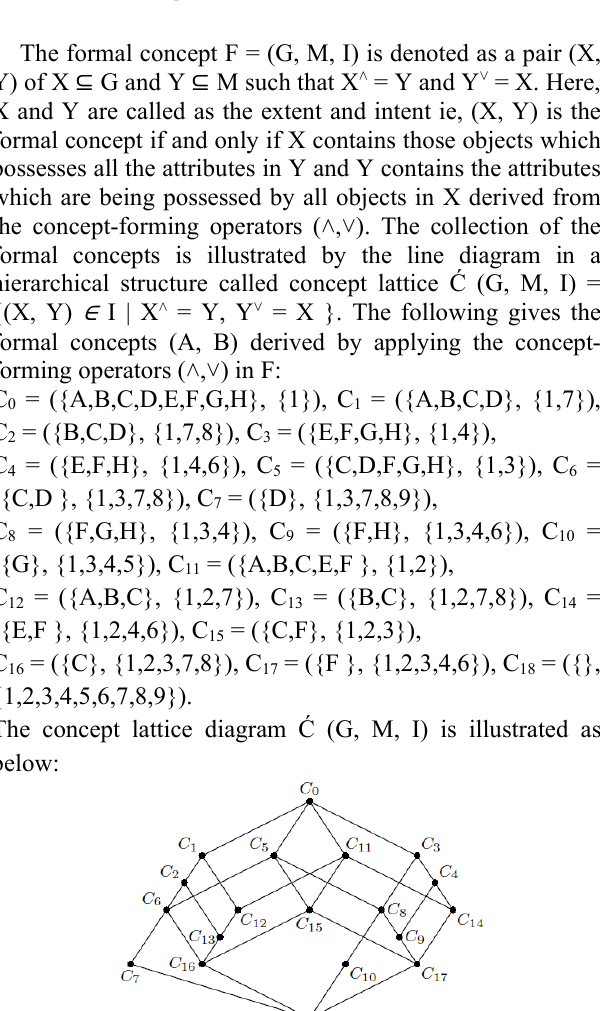
Figure 1. Formal context F